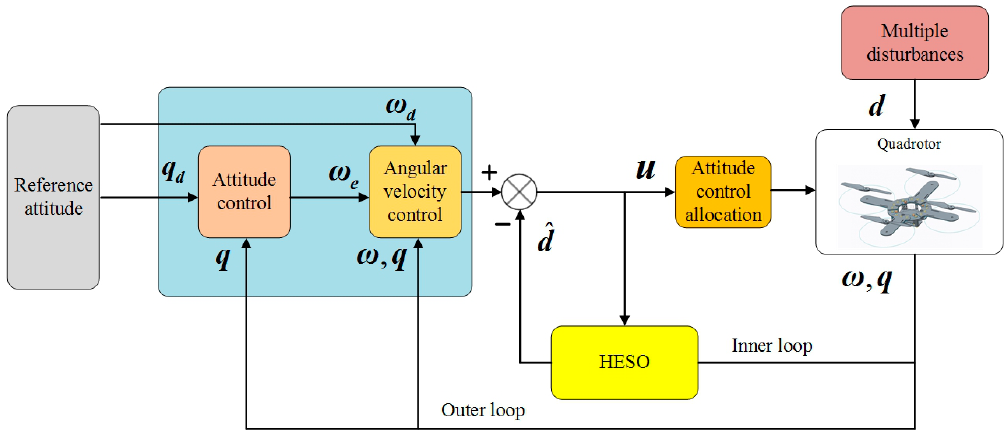
Figure 2. Block diagram of the proposed control scheme.